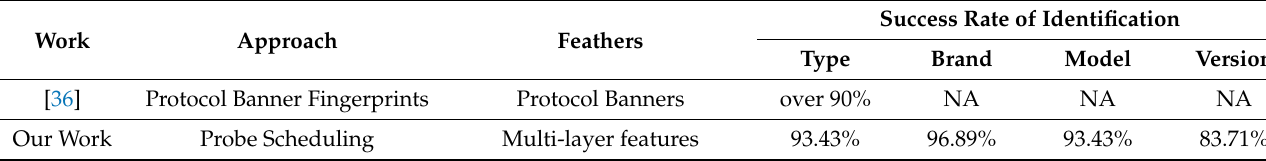
Table 3. Success rate compared with other